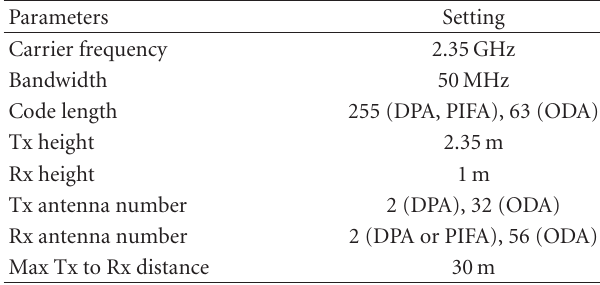
Table 1: Measurement parameters setting.